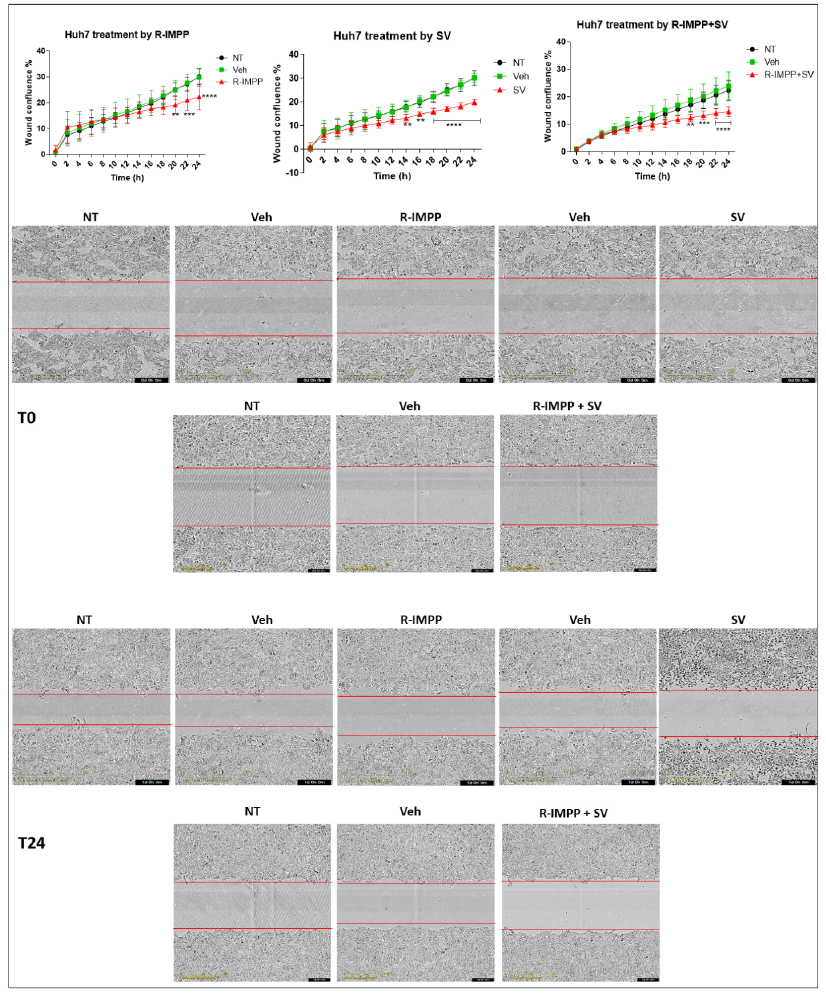
Figure 3. Effect of pharmacological inhibition of PCSK9 by R-IMPP on cellular migration. Effect of inhibition of PCSK9 by R-IMPP and/or HMGCR by SV on Huh7 cell migration in a wound healing assay using IncuCyte. Wound-healing confluence was followed for up to 24 h after treatment with 10 µM R-IMPP or 25 µM SV or a combination of both. NT refers to non-treated cells. Veh stands for R-IMPP (0.001% DMSO) and SV (0.001% ethanol) solvents. Two-way ANOVA test. ** p < 0.01; *** p < 0.001; **** p < 0.0001. Based on these results, it seems that among both targeting strategies, inhibiting PCSK9 alone was effective by itself not only in inhibiting cell proliferation but also cell migration in which simvastatin has no additive value. Taking into account these data, we